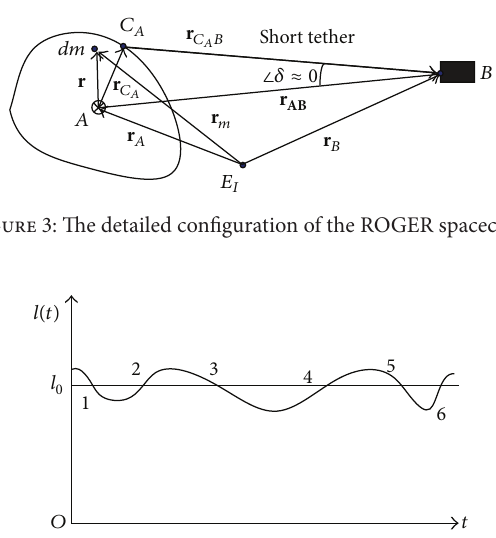
Figure 4: The length of the tether with the critical points